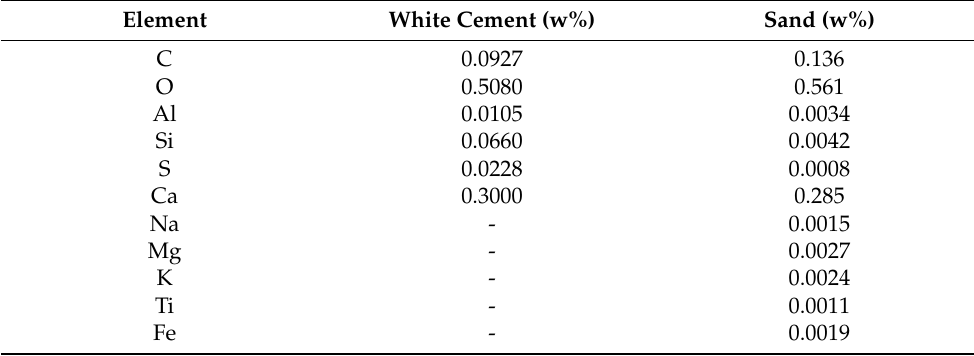
Table 1. Mineral chemical composition as weight fraction in percentage (w%).